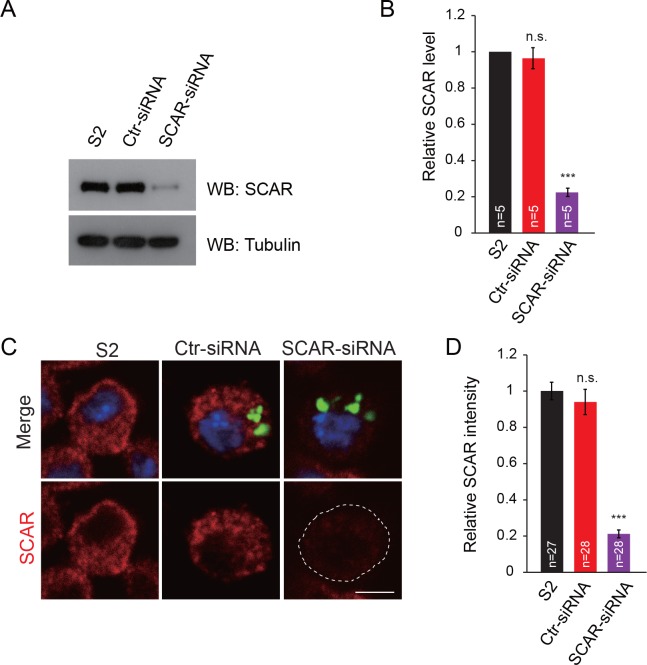
Examination of SCAR expression and distribution in S2 cells by siRNA.(A) S2 cells were transfected with control siRNA (Ctr-siRNA) or SCAR siRNA or for 3 days, and the resulting lysates were subjected to western blots with anti-SCAR antibody, using tubulin as a loading control and nontransfected S2 cells as a positive control. (B) Quantitative analysis of the SCAR level in (A). (C) Same as (A); nontransfected and transfected cells were immunostained with anti-SCAR antibody (red) and DAPI (blue). Note that siRNA foci were labeled with FAM (carboxyfluorescein) to indicate transfection. (D) Quantitative analysis of the SCAR intensity in (C). The data in (B) and (D) are shown as mean ± SEM; n represents the number of replicate experiments in (B) and the number of cells analyzed in (D); asterisks indicate significant differences between the WT and the indicated genotypes. ***p<0.001; n.s., not significant. Scale bar: (C) 5 μm.10.7554/eLife.30457.012Figure 3—figure supplement 2—source data 1.Sample size (n), mean, SEM, and one-way ANOVA (and nonparametric) Turkey's multiple comparisons test are presented for the data in Figure 3—figure supplement 2B and D.